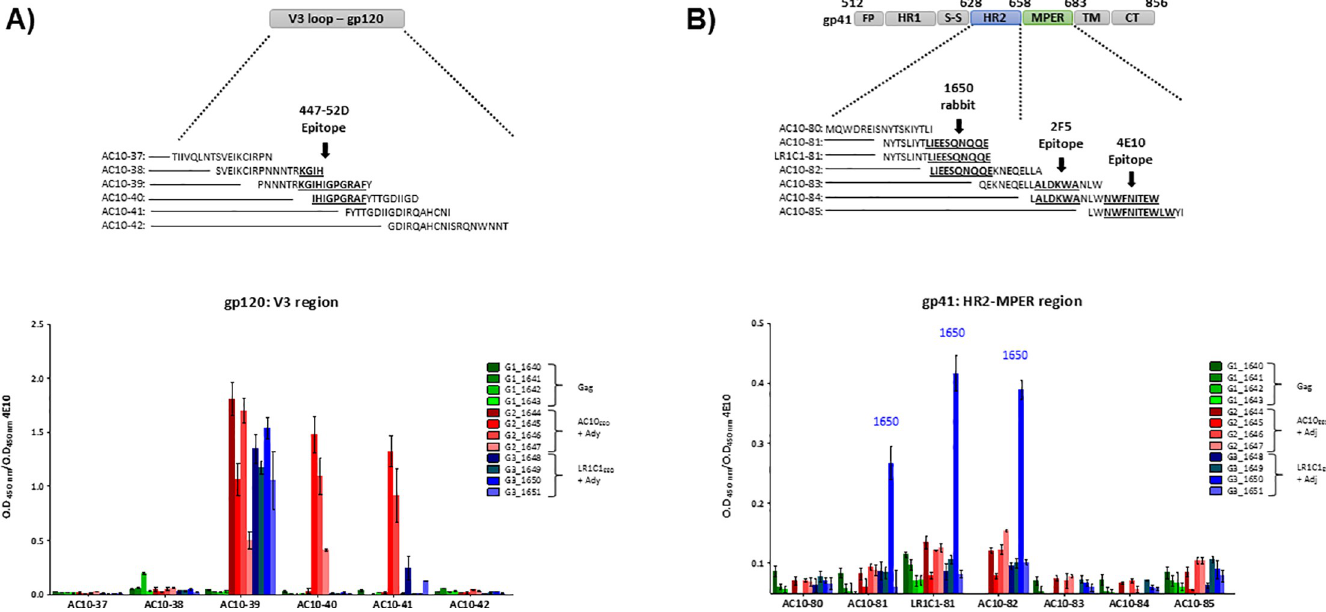
Fig 8. Characterization of the antibody responses against the V3-loop and the gp41 ectodomain regions. (A) Reactivity of sera from immunized rabbits to the V3 loop was analyzed by ELISA of overlapping 15-mer peptides corresponding to the V3 loop of the AC10_29 isolate. Peptide sequences are shown and the 447-52D epitope is indicated. (B) Reactivity of sera from immunized rabbits to the gp41 ectodomain was analyzed by ELISA of overlapping 15-mer peptides corresponding to the gp41 ectodomain of the AC10_29 isolate and one peptide with the LR1C1 sequence. Peptide sequences are shown and the 4E10 and 2F5 epitopes are also indicated.